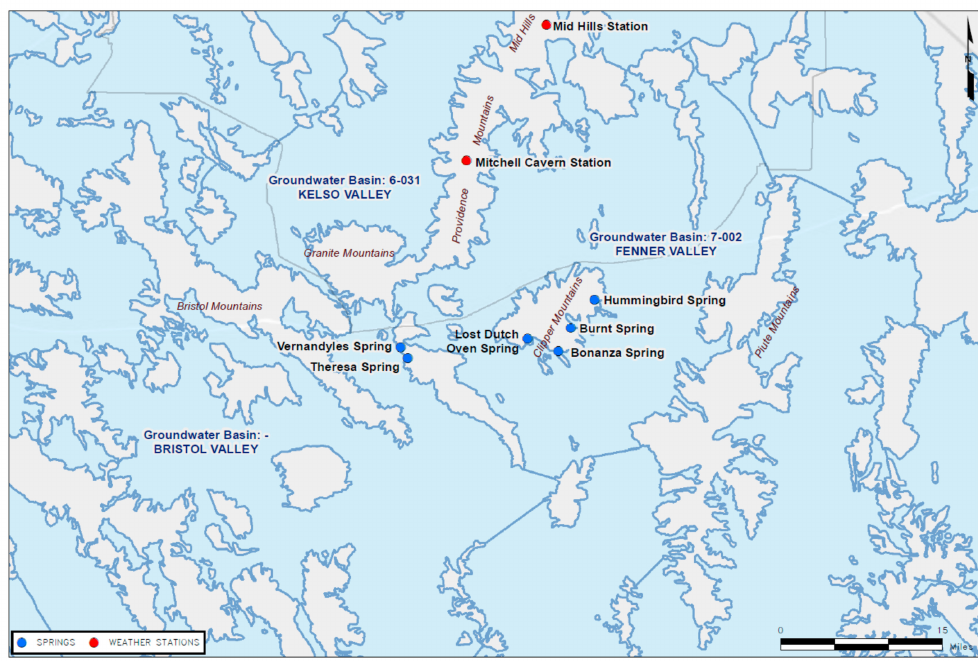
Figure 4. Groundwater basin map [5] with the location of the springs and weather stations investigated within the Mojave Trails National Monument. Solid blue lines divide the groundwater basins. Springs in this study are all within the Bristol Valley and Fenner Valley groundwater